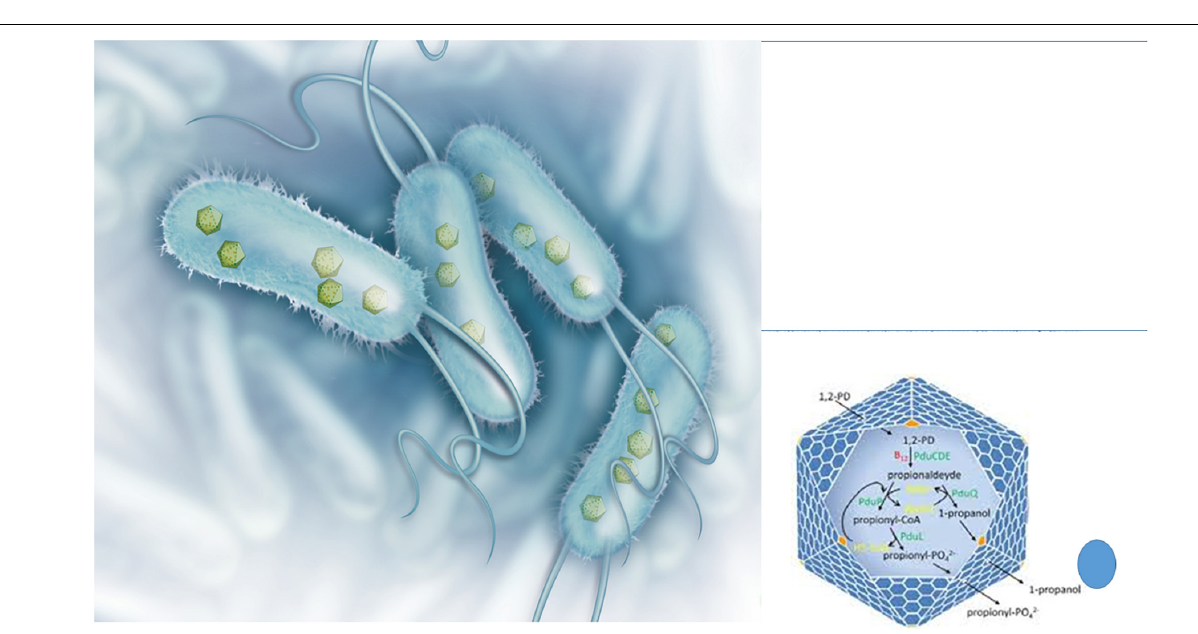
FIGURE 3 | Bacterial structures showing similarities with phages: protein shell microcompartments and the phage head.Microcompartments are used for isolating metabolic pathways generating toxic compounds such as 3-hydroxypropionaldehyde ( on the left : illustration originally printed in The Scientist by Thom Graves; on the right : from Lundin et al.,